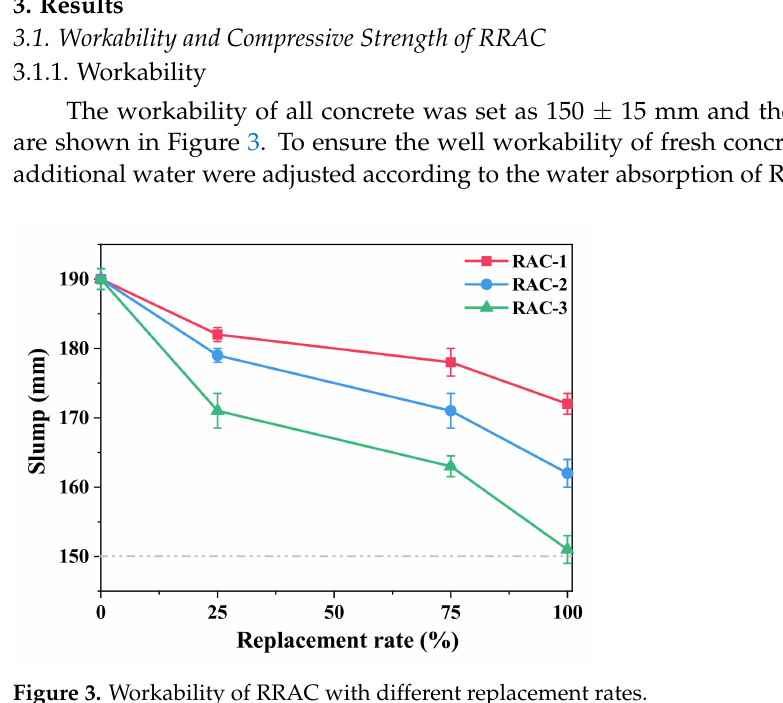
satisfied the design index. But the slump values of RRAC were lower than that of NAC, increased. Compared with NAC, the slump values of RAC-1-25, RAC-2-25, and RAC-3-25 reduced by 4.2%, 5.8%, and 10.0%, respectively. For RAC-3, the slump values declined